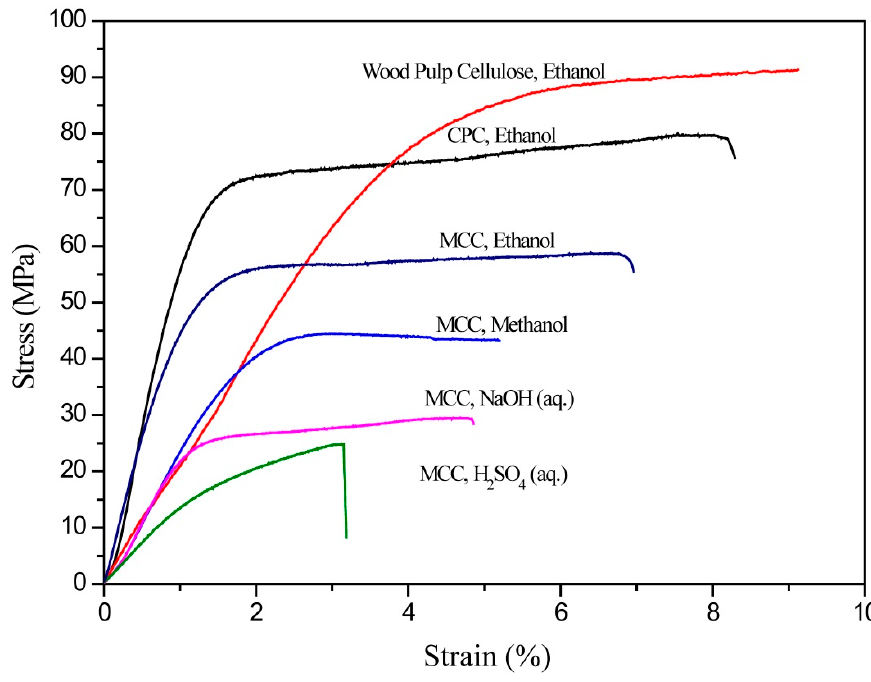
Figure 7. Stress–strain curves of films.